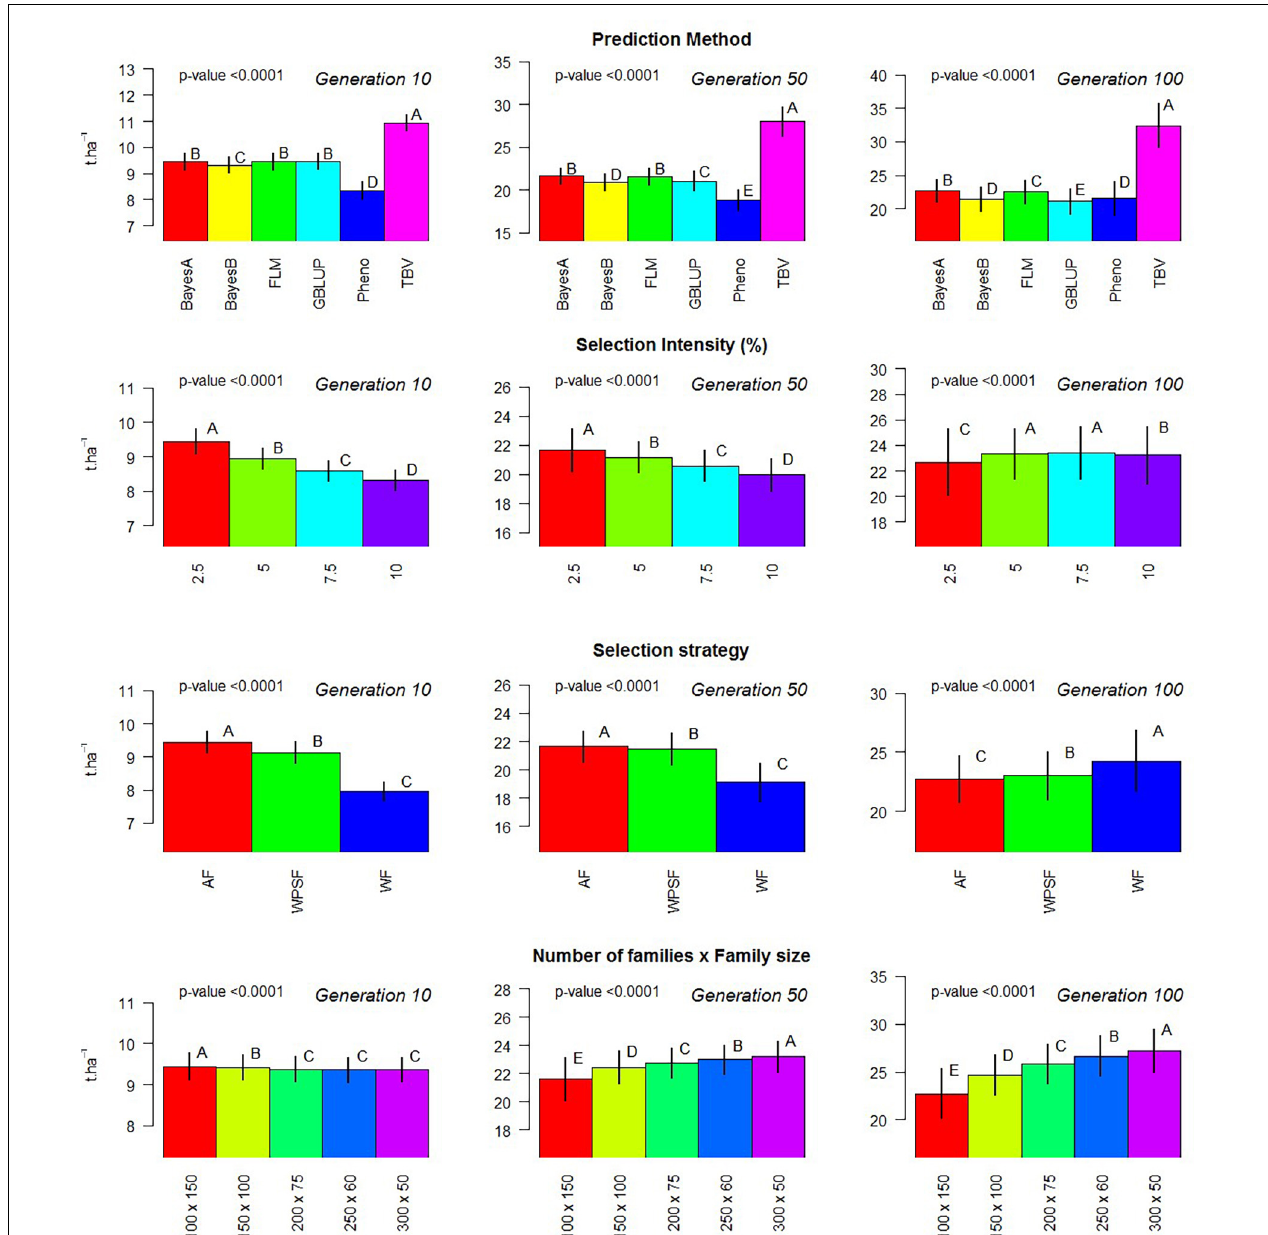
FIGURE 2 | Evaluation of individual factors on population means. Multiple comparison test: Capital letters indicate difference in means across factor with Tukey’s range test with 5% alpha level contrasting the levels of each factor (prediction method, selection intensity, balance between population size and family size, and breeding strategy) on generations 10, 50, and